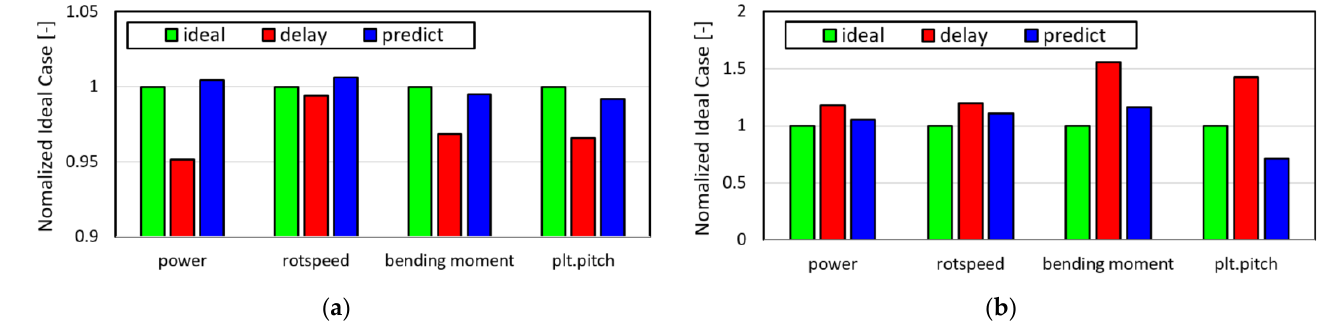
Figure 18. ( a ) Average values and ( b ) standard deviations of four output variables according to pitch controller. (power, rotational speed, bending moment , platform pitch).